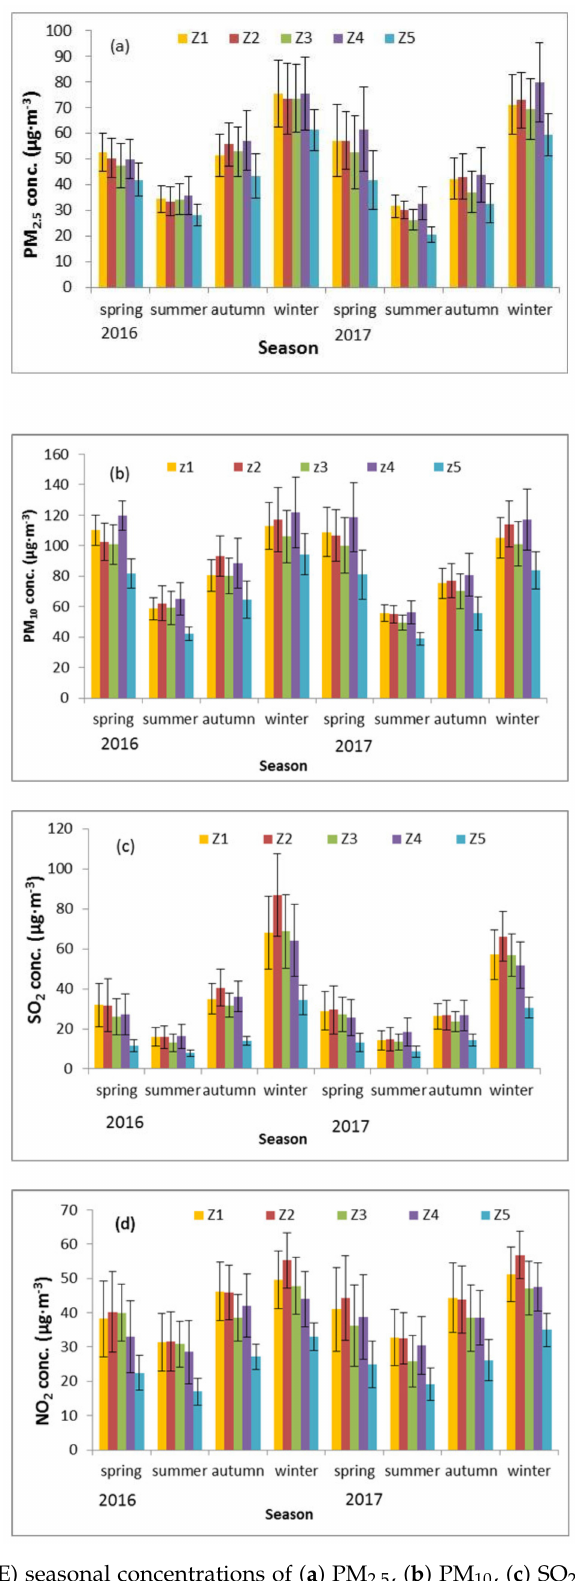
Figure 3. Mean ( ± SE) seasonal concentrations of ( a ) PM 2.5 , ( b ) PM 10 , ( c ) SO 2 , and ( d ) NO 2 in five ecological functional zones in Shenyang from January 2016 to December